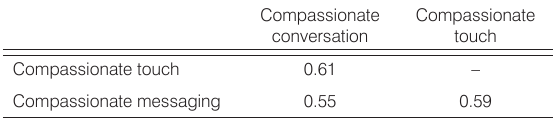
Table 3. Inter-subscale correlations and reliability coefficients of each subscale ( N = 267).